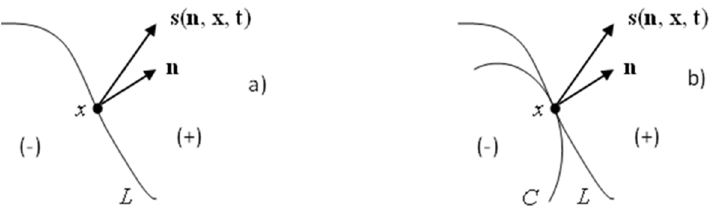
Figure A1. Existence of the surface force density s ( n , x , t ) between the surfaces L and C